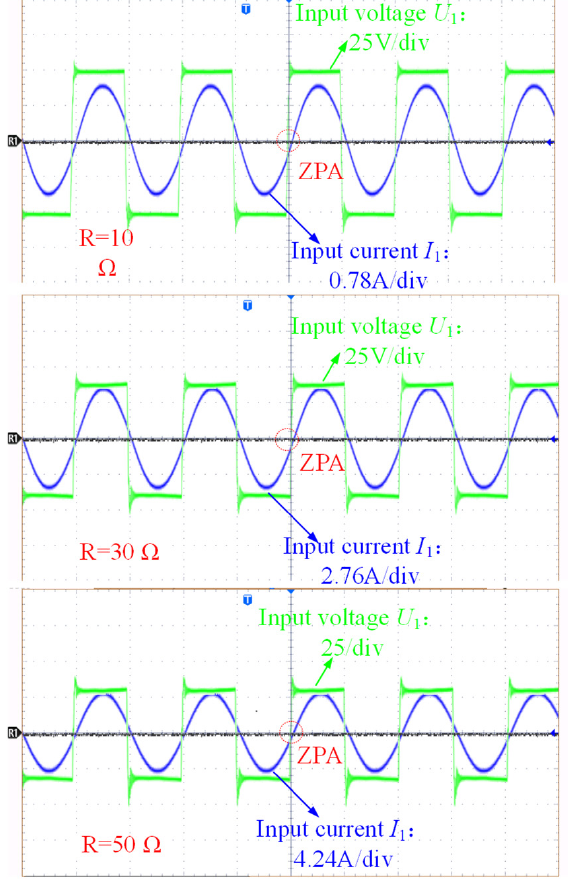
Figure 16. The input voltage and current waveform of the WPT system after adding a PI coil under different loads.